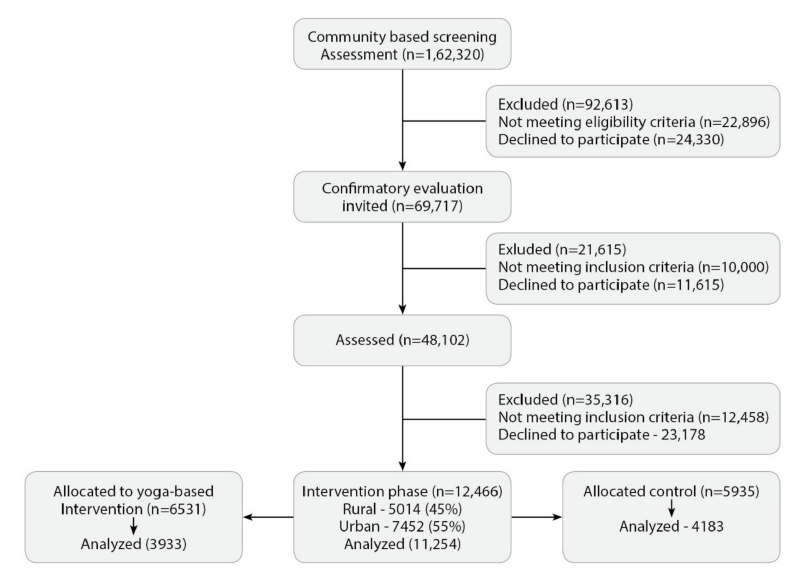
Figure 1. CONSORT diagram of the